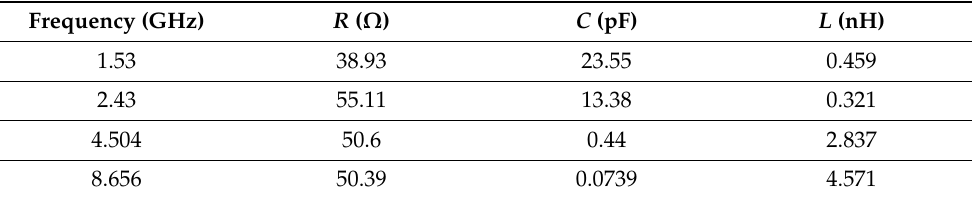
Table 2. RLC parameters of the equivalent circuit.